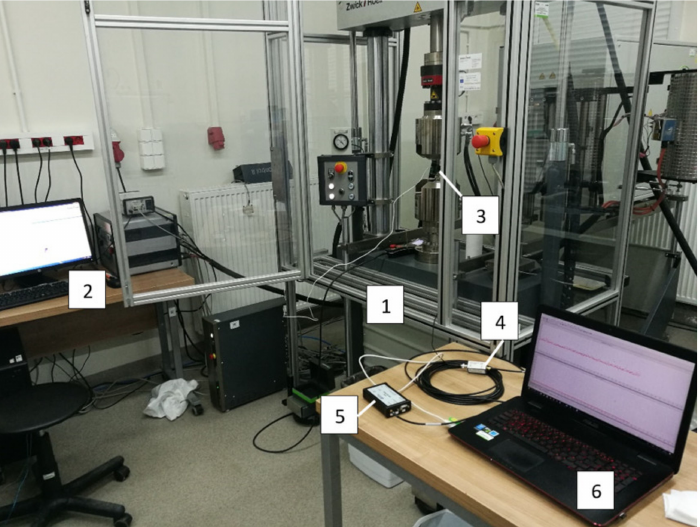
Figure 3. General view of laboratory stand: 1–tensile stress machine, 2–tensile stress